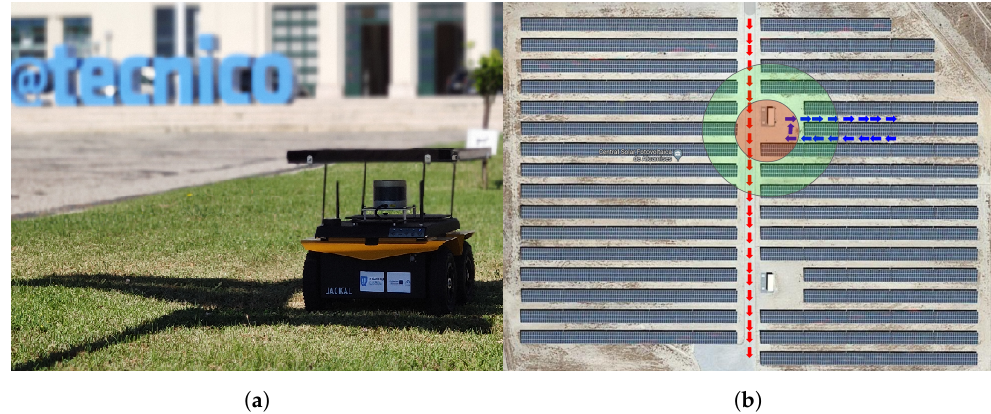
Figure 2. Real-world experimental setup. ( a ) Clearpath Jackal. ( b ) Path taken.